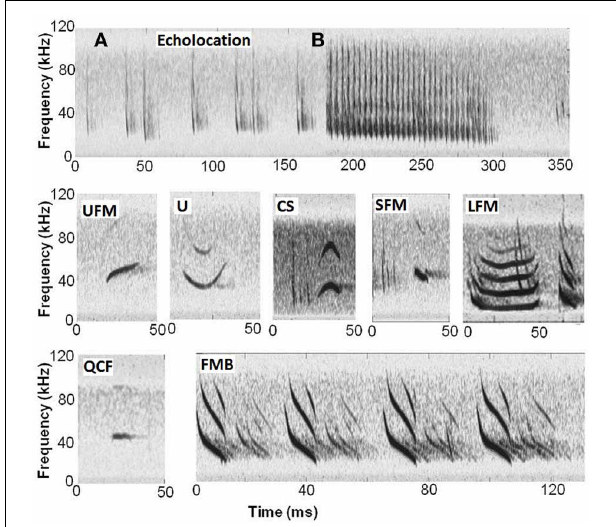
FIGURE 1 | Calls recorded in a flight room. (A) Standard echolocation calls (two bats flying); (B) feeding buzz with the second bat echolocating; UFM, upward frequency-modulated;U, U-shaped; CS, chevron-shaped; SFM, short frequency-modulated;LFM, long frequency-modulated (double-LFM showing long and short varieties of the call type); QCF, quasi-constant frequency; and FMB, frequency-modulatedbout with only the initial FM sweeps shown (four pulses and their echoes are shown). Note that for several of the examples above (e.g., CS, SFM, and LFM), echolocation calls from the other bat present in the trial are also